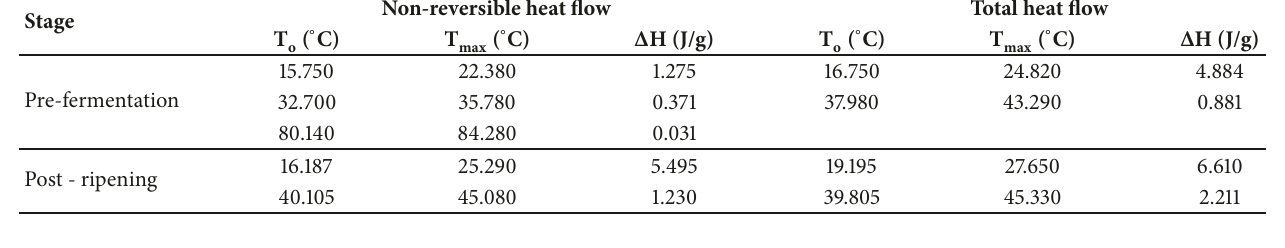
), maximum temperature (T ), and enthalpy ( Δ H) of the lipid fractions of salami o max